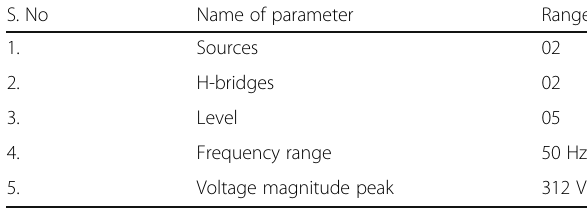
Table 1 Design parameters for Cascaded Multilevel